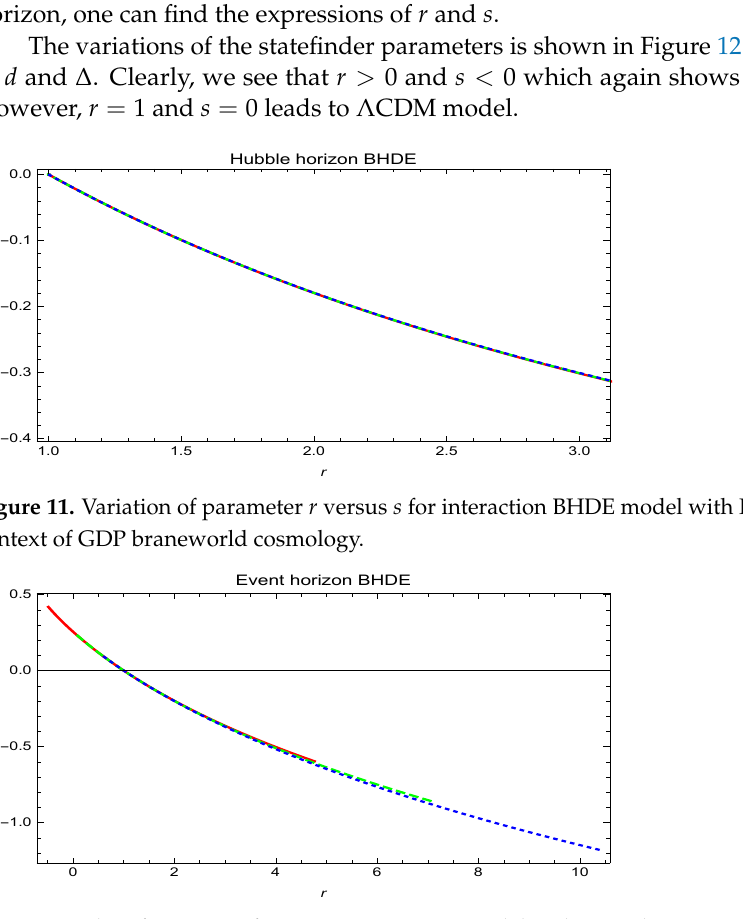
Figure 12. Plot of r versus s for interaction BHDE model with event horizon under GDP braneworld